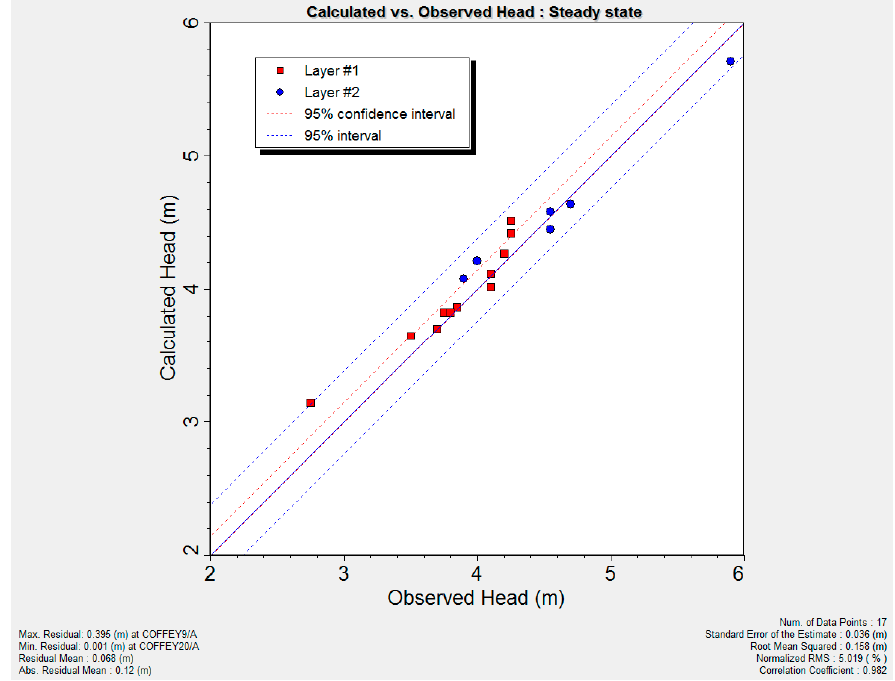
Figure 8. Comparison of observed head versus calculated head-scenario 1.